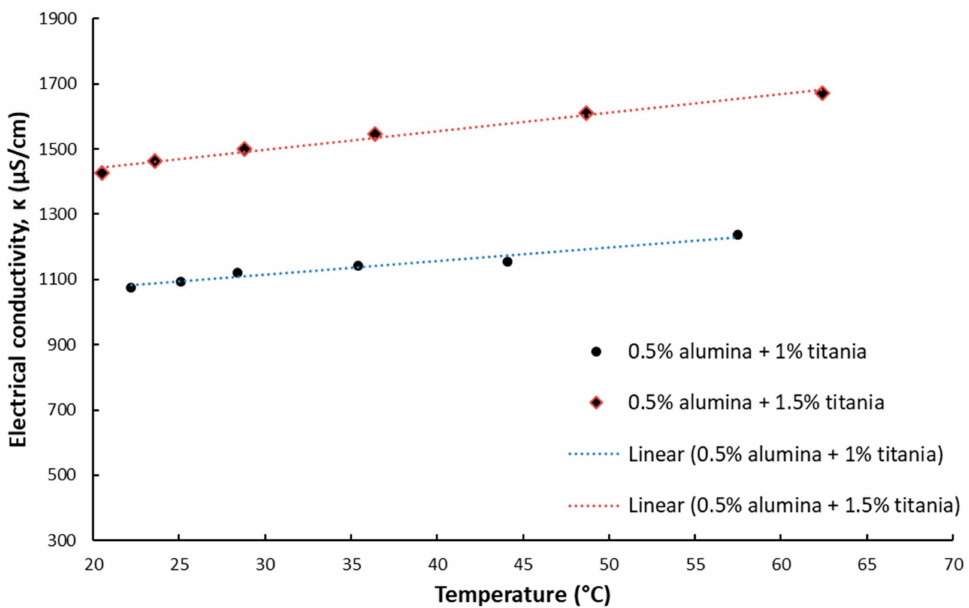
Figure 6. Experimental results on alumina + titania hybrid nanofluid electrical conductivity variation with temperature. Table 2. Correlations for electrical conductivity variation with temperature. Nanofluid Type and